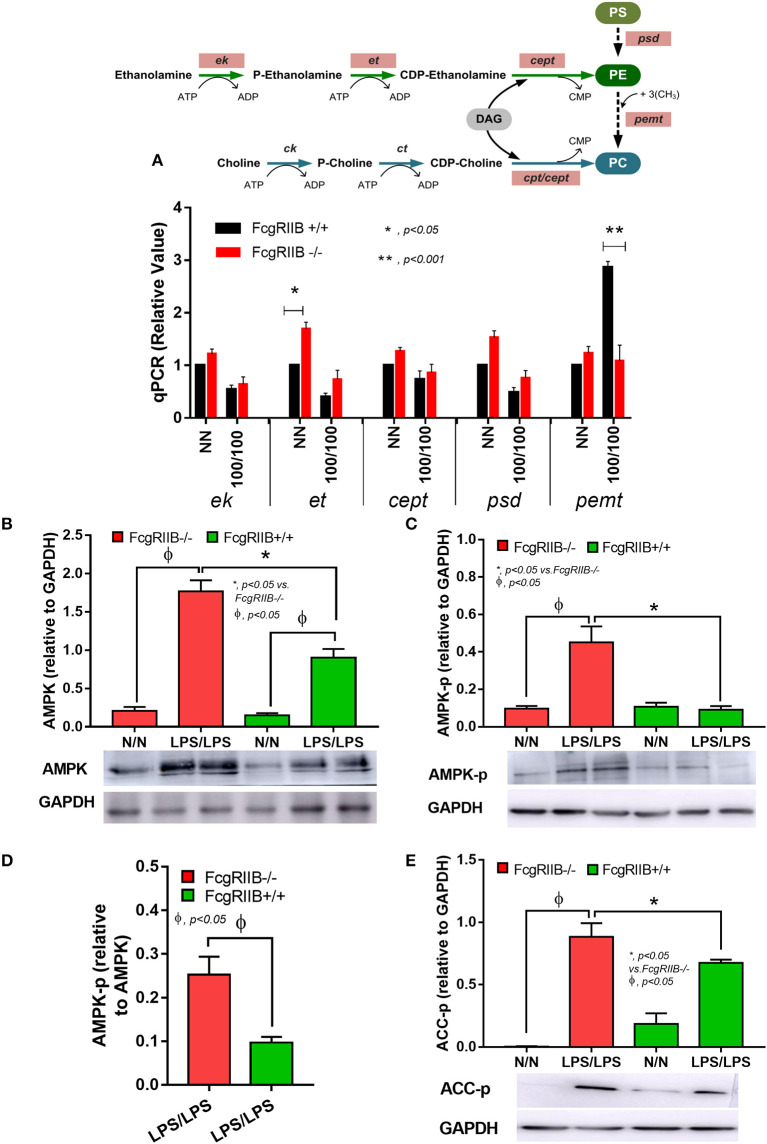
Schematic diagram of important enzymes including ethanolamine kinase (ek), CTP: phosphoethanolamine cytidylyltransferase (et), choline/ethanolamine phosphotransferase (cept), phosphatidylserine decarboxylase (psd), phosphatidylethanolamine N-methyltransferase (pemt), and CTP-phosphocholine cytidylyltransferase/choline/ethanolamine phosphotransferase (cpt/cept) in lipogenesis pathway with phosphatidylserine (PS), phosphatidylyethanolamine (PE), and phosphatidylcholine (PC) (A, upper part) and gene expression from macrophages from FcgRIIB–/– and wild-type (FcgRIIB+/+) in control (N/N) or LPS-tolerance (100/100) (A, lower part) are demonstrated (DAG, diacyl glycerol). Protein abundance of macrophages in control (N/N) or LPS-tolerance (100/100) as determined by AMP-activated protein kinase (AMPK) in relative to Glyceraldehyde 3-phosphate dehydrogenase (GAPDH) (B), phosphorylated AMPK (AMPK-p) in relative to GAPDH (C), AMPK-p abundance in relative to AMPK (D), and phosphorylated acetyl-CoA carboxylase (ACC-p) (E) of LPS-tolerant macrophages with representative pictures of Western blot analysis are also demonstrated (Independent triplicate experiments were performed).